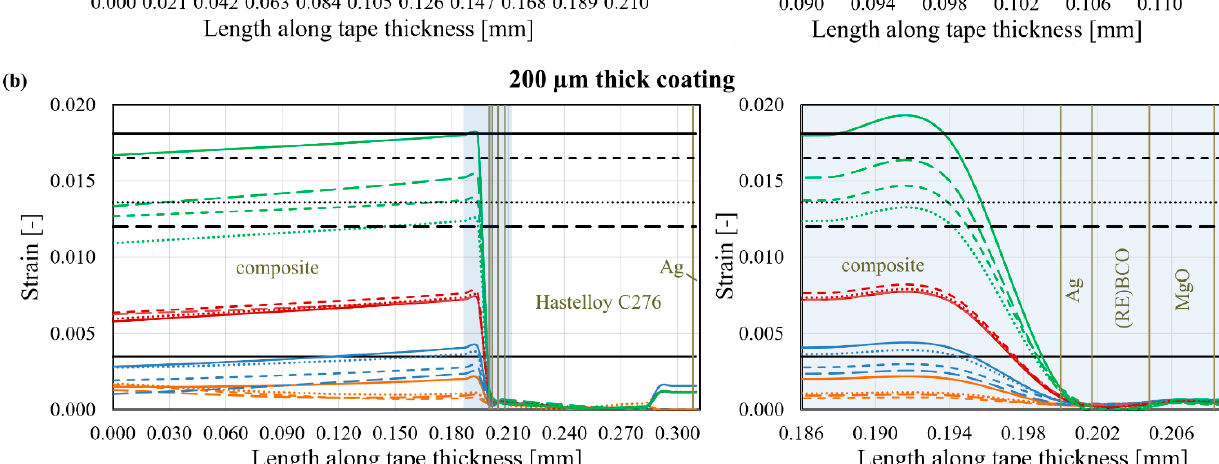
Figure 10. Equivalent strain of longitudinal path along the composite layer of tape: ( a ) model with 100 µm and ( b ) 200 µm thick composite coating, different SiC content and various quenching temperatures. For better clarity, only a half of the tape length is plotted; the strain distribution in the second half of the tape is approximately the mirror image of the oppo- site.